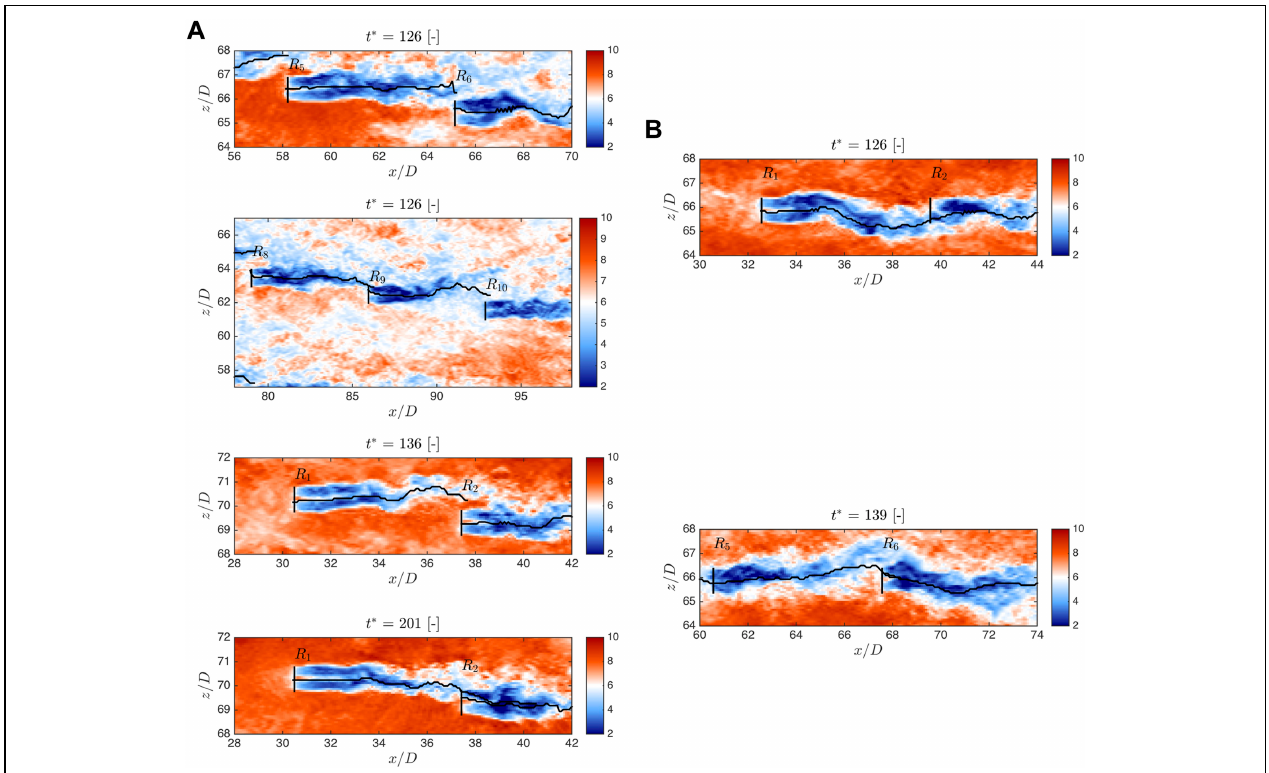
FIGURE 8 | Several snapshots of the streamwise velocity in a horizontal plane located at hub height, centered around some rows, for wind directions α w = 262 ° (A) and α w = 270 ° (B) . The units are in